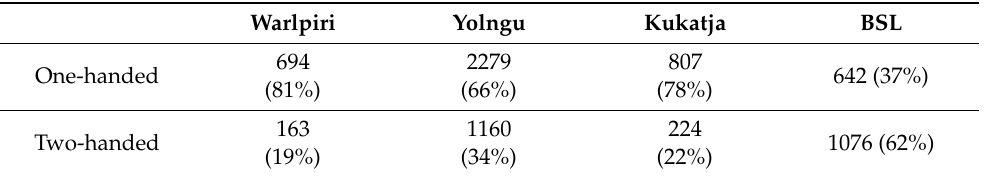
Table 5. Percentage of one vs. two-handed sign tokens 21 in three Australian Indigenous sign languages and